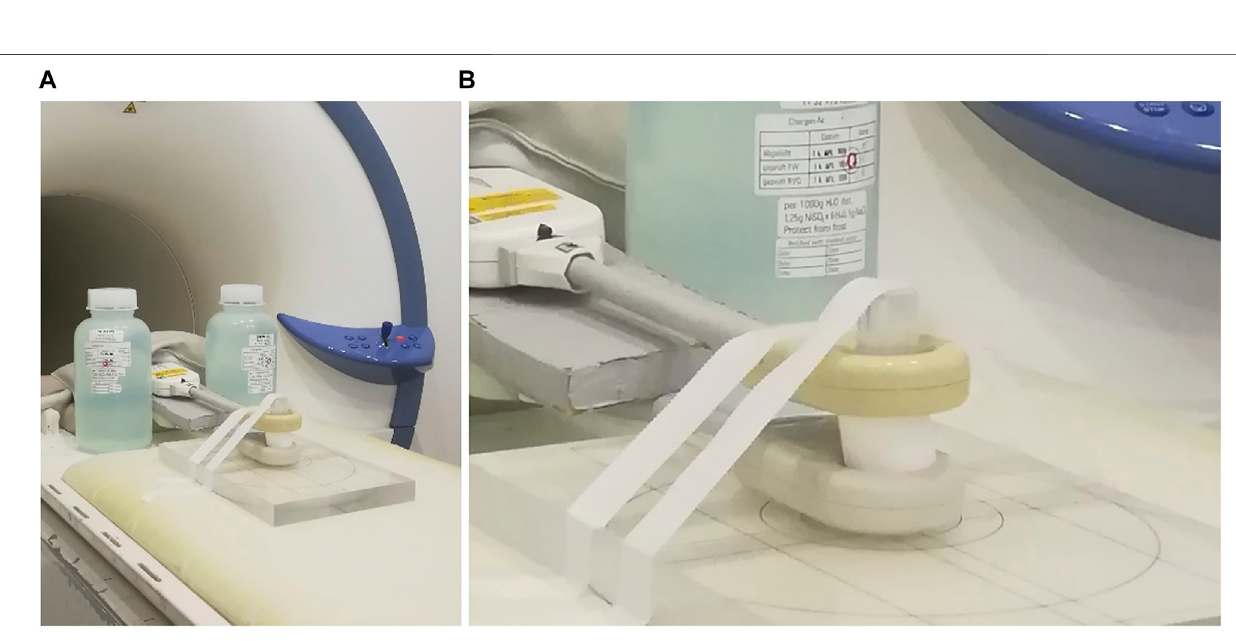
Frontiers in Physics |